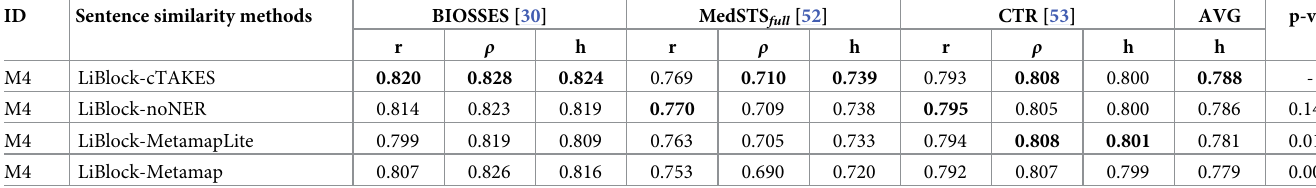
Table 12. Pearson (r) and Spearman ( ρ ) correlation values, harmonic score ( h ), and harmonic average (AVG) score obtained by the LiBlock method in combination with each NER tool using the best pre-processing configuration detailed in Table 7. In addition, the last column (p-val) shows the p-values for the comparison of the LiBlock method with cTAKES and the remaining NER